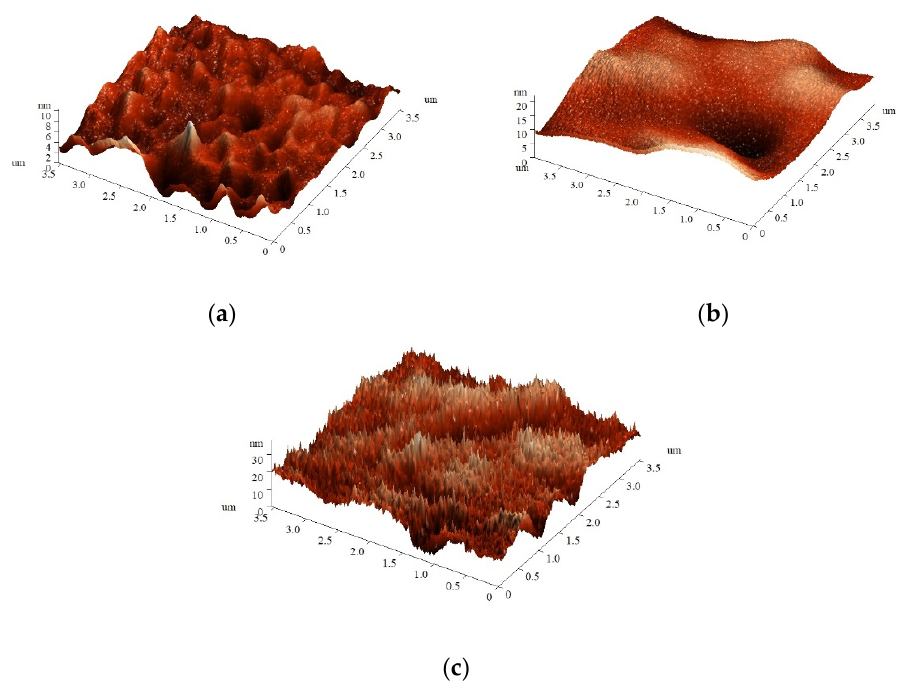
Figure 2. Atomic force microscopy images of ( a ) the initial PLA film and PLA films treated ( b ) at the cathode and ( c ) at the anode.